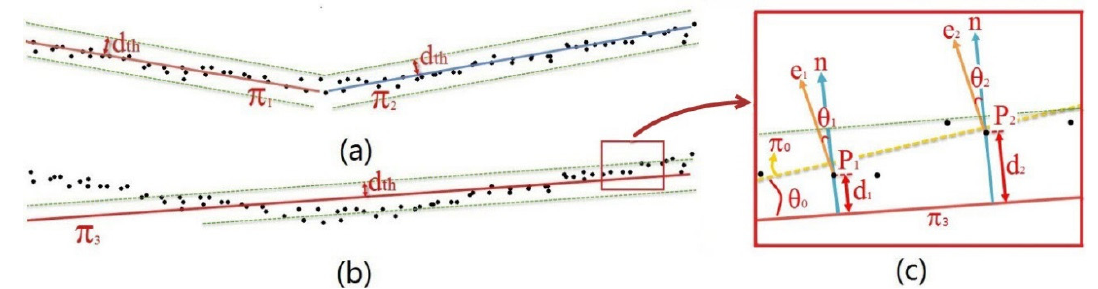
Figure 1. An example of spurious planes. ( a ) The well estimated hypothesis planes ( π 1 and π 2 ); the two green parallel lines are the boundary of the point-to-plane distance threshold; ( b ) A spurious plane ( π 3 ) is generated under the same thresholds; ( c ) A detail view of ( b ), where n is the normal vector of the plane π 3 , and e 1 and e 2 are the point normal vectors. The d 1 , d 2 , θ 1 , θ 2 are the corresponding observed values of point P 1 and P 2 in Equation (2). θ 0 is the angle between π 3 and the real roof surface ( π 0 ).